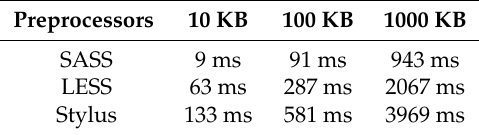
Table 7. Performance